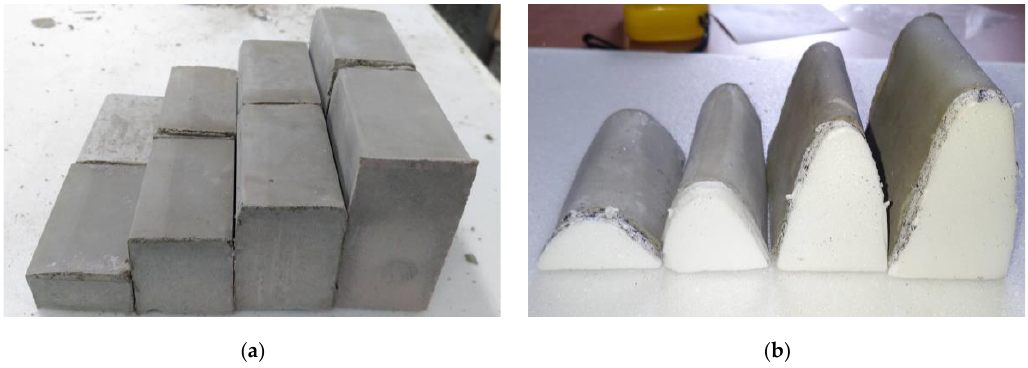
Table 1. Combination of breakwaters sets. Figure 3. Single ( a ) rectangular and ( b ) undulating breakwater set.